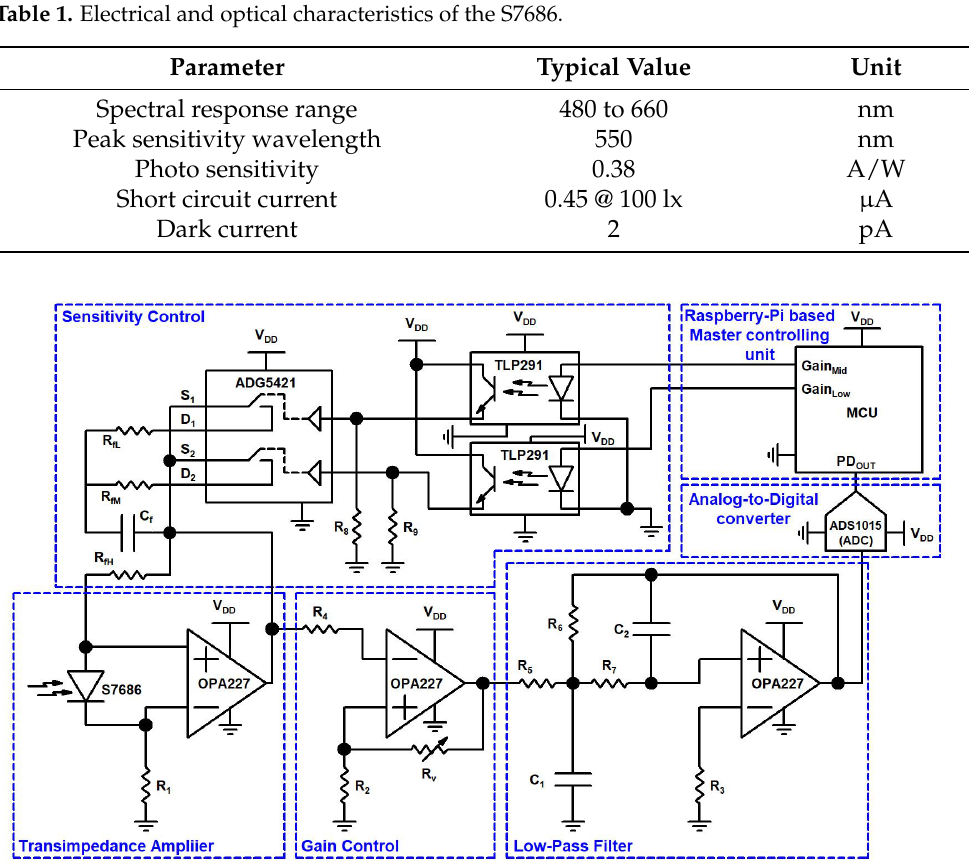
Figure 3. Circuit diagram of the V-VLC RX